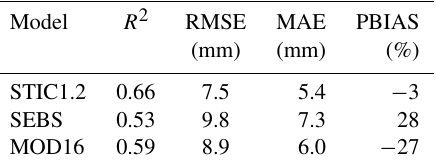
Table 3. Evaluation of 8-day cumulative ET from STIC1.2, SEBS, and MOD16 against observed ET from 13 core AmeriFlux sites in the US combining data from one dry, one wet, and one normal year. Model R 2 RMSE MAE PBIAS (mm) (mm) (%)